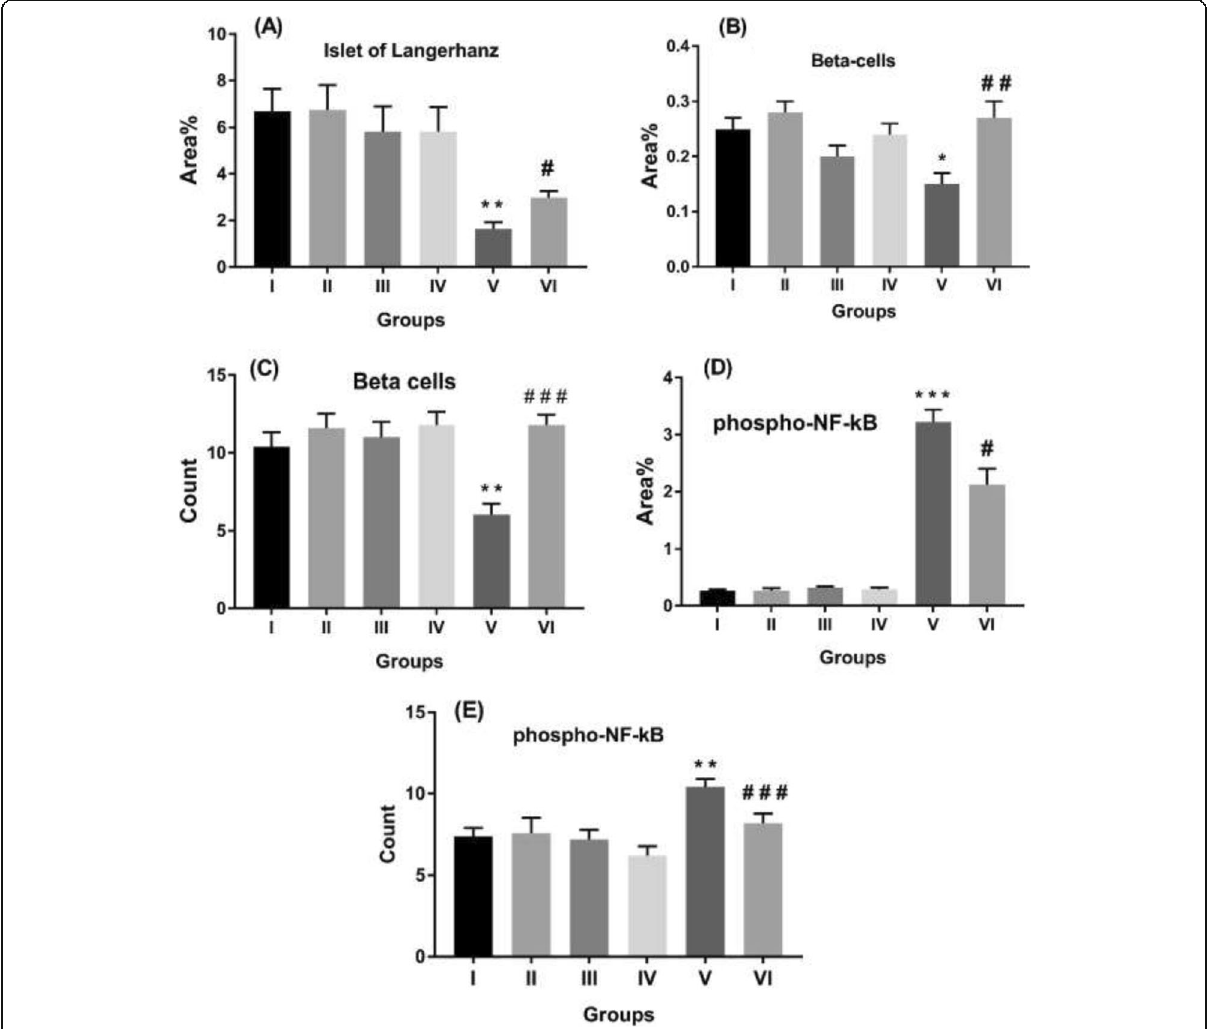
Fig. 3 Immunostaining expression of insulin and phospho-NF- κ B-p65 in pancreatic sections. For insulin ( a – c ), area percentage of Langerhans islets ( a ), area percentage of β cells ( b ), and count of β cells ( c ). For phospho-NF- κ B ( d and e ), area percentage ( d ) and count ( e ). Data were expressed as mean ± (SEM). Significantly (* P < 0.05, ** P < 0.01, and *** P < 0.001) compared to normal mice (group I). Significantly ( # P < 0.05, ## P < 0.01, and ### P < 0.001) compared to diabetic mice (group V). Normal mice (group I). Mice treated with citrate (group II), DEMSO (group III), or curcumin (170 mg/kg) (group IV). Diabetic mice induced by STZ (160 mg/kg) (group V). Diabetic mice treated with curcumin (170 mg/kg) (group VI). p-NF- κ B, phosphorylated-NF- κ B; DMSO,